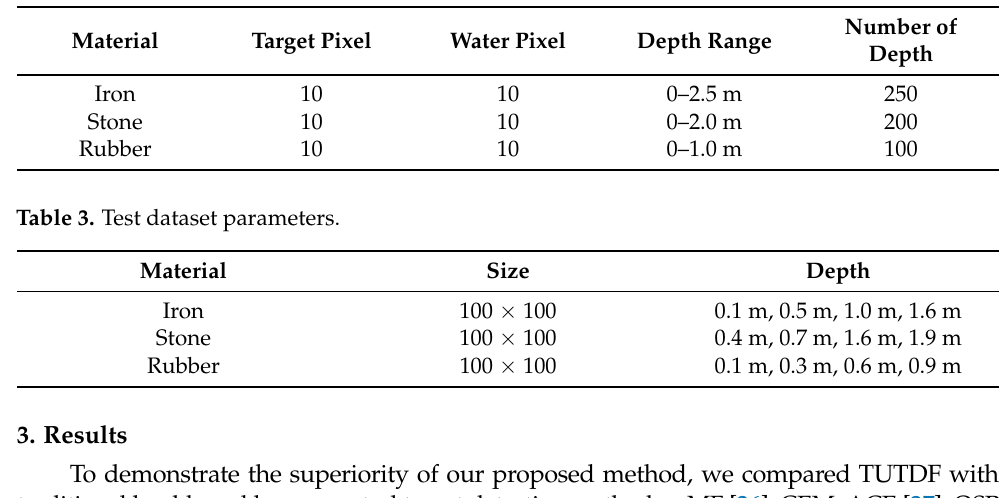
Table 2. Depth estimation network training dataset parameters.